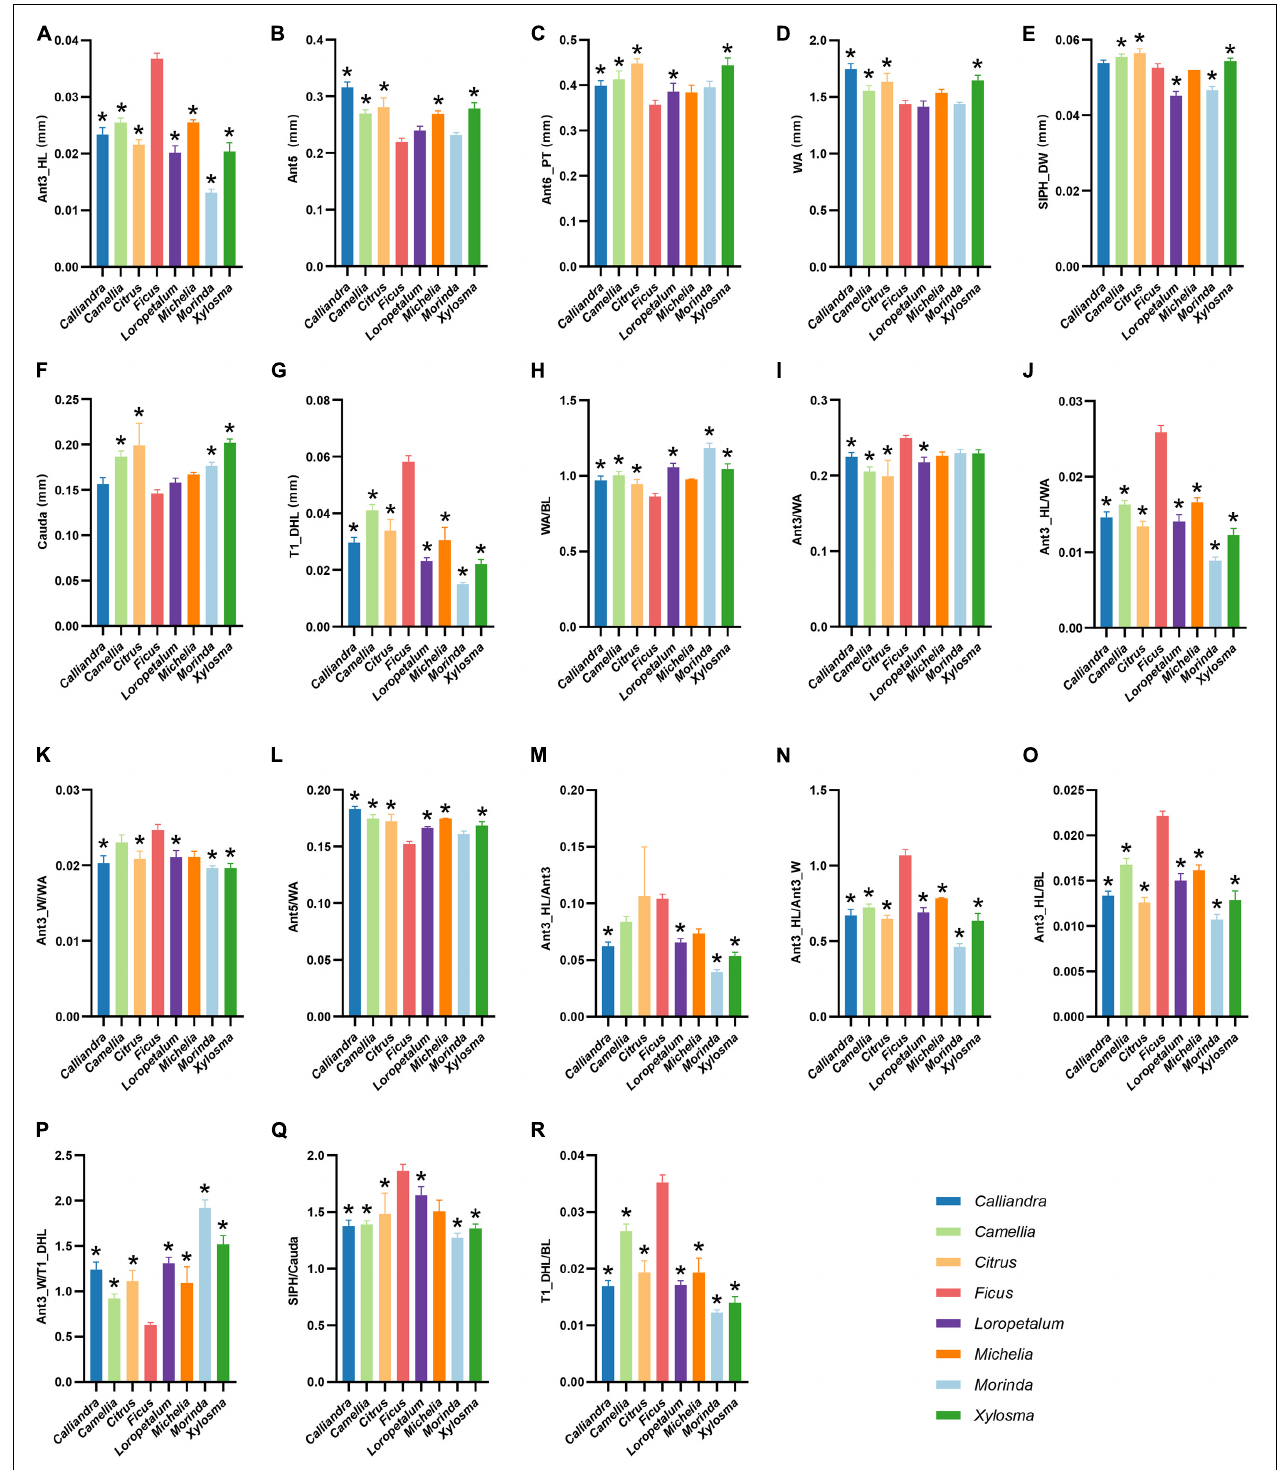
FIGURE 3 | Eighteen morphological characters with significant difference between A. aurantii populations feeding on Ficus and other plant genera, including Ant3_HL (A) , Ant5 (B) , Ant6_PT (C) , WA (D) , SIPH_DW (E) , Cauda (F) , T1_DHL (G) ; ratios of WA/BL (H) , Ant3/WA (I) , Ant3_HL/WA (J) , Ant3_W/WA (K) , Ant5/WA (L) , Ant3_HL/Ant3 (M) , Ant3_HL/Ant3_W (N) , Ant3_HL/BL (O) , Ant3_W/T1_DHL (P) , SIPH/Cauda (Q) , T1_DHL/BL (R) . Different color bars represent samples from different host plant genera. *Represents host-populations significantly different with the Ficus population.